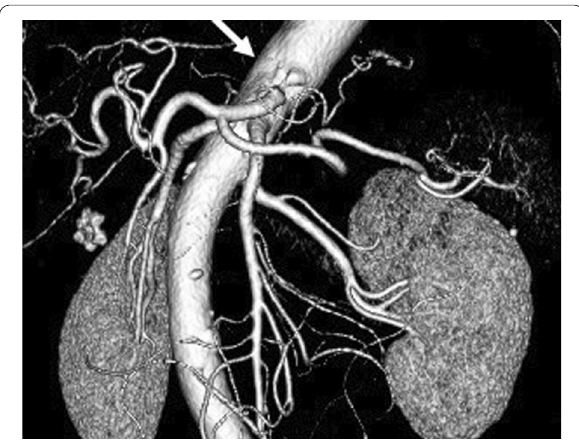
Fig. 2: 3-D CT angiography showed stenosis of the celiac artery due to MALS